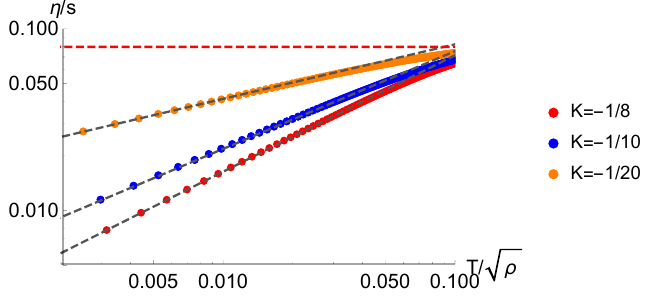
√ Figure 10 . The η/s ratio as the function of T/ ρ for K ∈ [ − 1 / 8 , − 1 / 20] (red-orange). The dots are numerical results obtained by (2.16). The black dashed lines are analytical results obtained by (A.33) in the low temperature limit. The red dashed line is the KSS bound. We have fixed coupling λ = 0